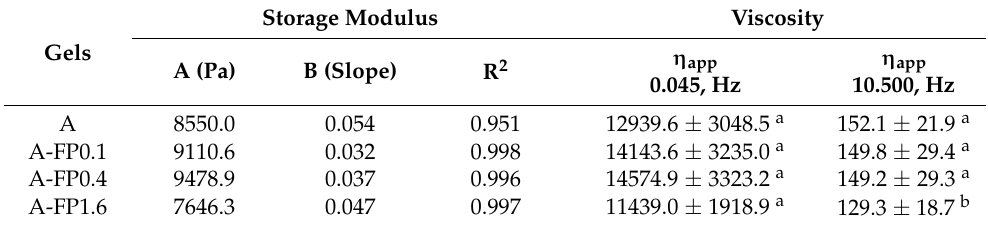
Mean ± SD. Different letters among gels— p < 0.05 ( n =